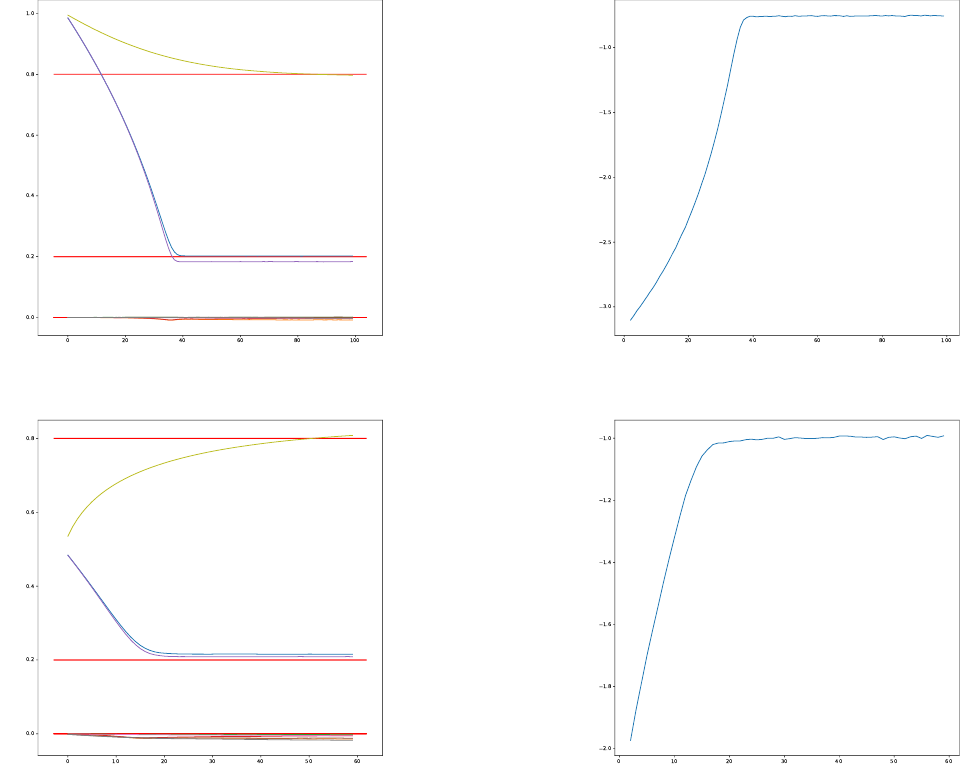
Figure 4. The importance sampling technique applies to estimate the metric on the Lie group SO ( 3 ) . Sampling a Brownian motion from an underlying unknown metric, we obtain convergence to the true underlying metric using an iterative MLE method. Here, we sampled four guided bridges per observation, providing a relatively smooth iterative likelihood. ( Top left ) Estimation of the unknown underlying metric using bridge sampling, starting from the metric diag ( 1,1,1 ) . Here, the true metric is the diagonal matrix diag ( 0.2,0.2,0.8 ) represented by the red lines. The diagonal is represented by the colors diag (purple, blue, yellow). ( Top right ) The corresponding log-likelihood evolution through the iterations. ( Bottom left ) Estimation of the unknown underlying metric using bridge sampling, starting from the metric diag ( 0.5,0.5,0.5 ) . ( Bottom right ) The corresponding iterative